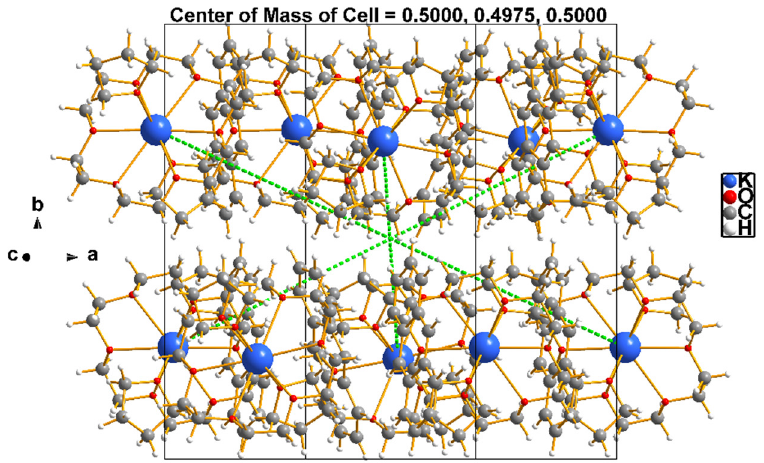
Figure 10. The packing of the cations and anions of the unit cell, shown approximately down the c -axis. The center of mass for these species is displayed at the intersection of the dotted green lines, located at 0.5000, 0.4975, 0.5000, which is nearly exactly at ½, ½, ½. However, recall that the space group is P2 1 , where the origin for y is arbitrary. This fact is consistent with the kryptoracemic nature of this remarkable substance.